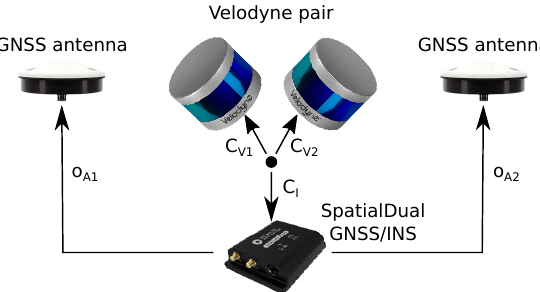
Figure 9. Extrinsic calibration required in our system. The mutual positions between the Velodyne scanners and the GNSS/INS unit are computed. The offsets (cid:126) o A 1 , (cid:126) o A 2 of the antennas are tape measured.